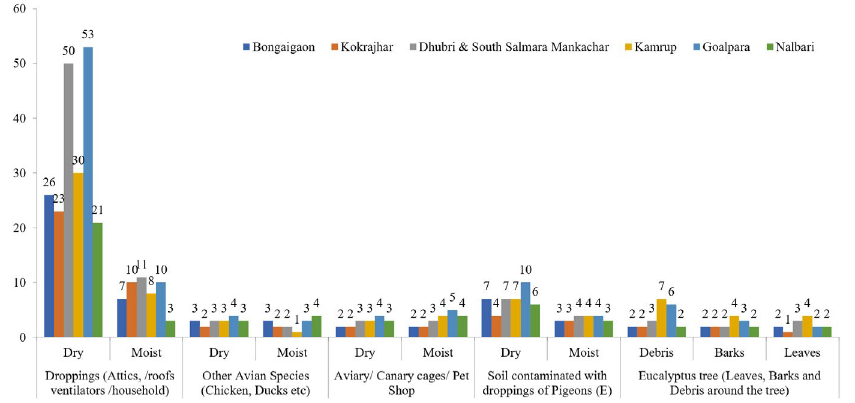
Fig. 2. Frequency distribution of samples as per their sources and types